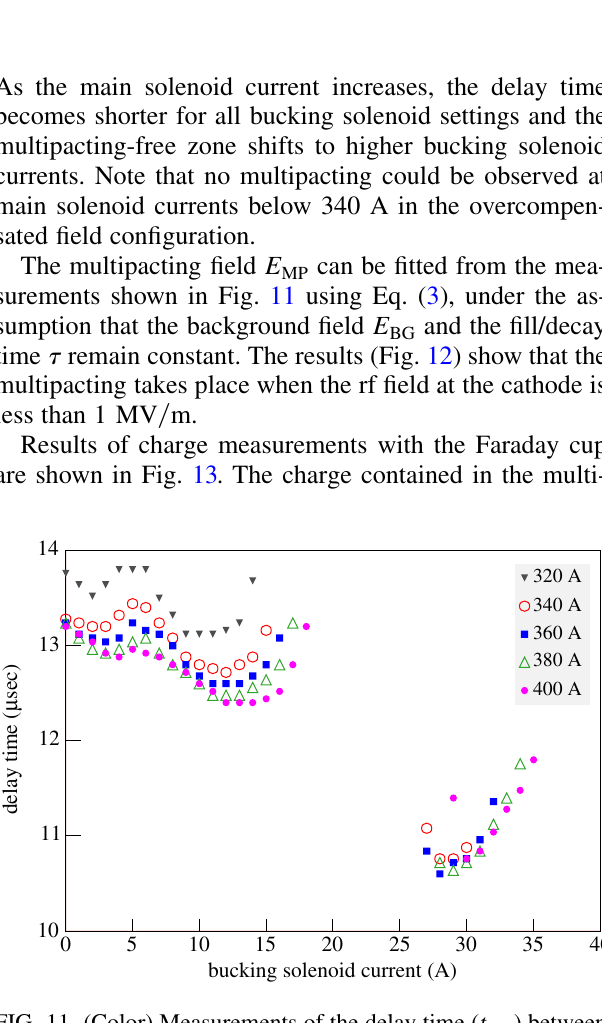
) between rear ) for bucking ). No multipacting is de- main